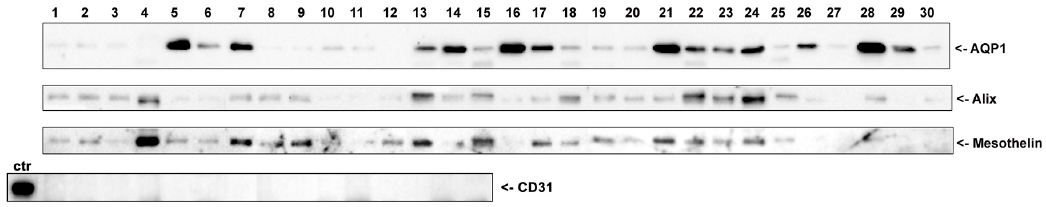
Figure 1. Samples of parietal and visceral (omentum) human peritoneum were analyzed by immunofluorescence with antibodies against AQP1 (green) and the surface marker of mesothelial (mesothelin) (red). Micrographs depict a longitudinal section of parietal mesothelium and a transversal section of visceral mesothelium. Colocalization (yellow) is highlighted in the merge panel. Comparable results were obtained in samples from three patients. 3.2. AQP1 Is Released by Mesothelial Cells in the PD Effluent through Exosomes (Qualitative Analysis) AQP1 is a membrane-spanning water channel that is constitutively localized at the cell plasma membrane in all the tissues where it is expressed [20]. Considering that in many epithelial cells, apical plasma membrane proteins can be released in the extracellular space in the form of exosomes [21], we wanted to determine if AQP1 could be released at measurable levels in the peritoneal cavity. To achieve this aim, nocturnal PD effluents from thirty PD patients were subjected to differential centrifugation to isolate an exosome-enriched fraction. As shown in Figure 2, a band at 28 kDa corresponding to AQP1 was revealed in almost all samples although this band had variable intensity. In the same samples, immunodetection showed a clear band for the exosome marker protein ALIX